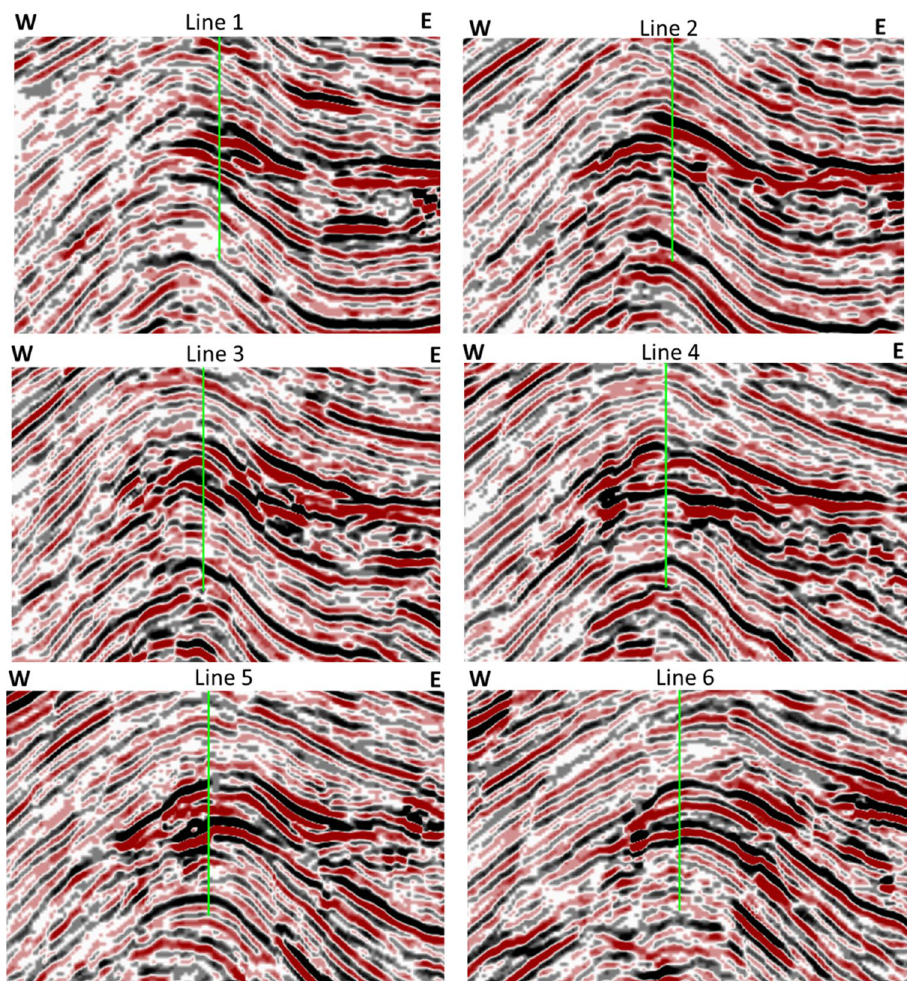
Fig. 10 Seismic lines around Well_1 (green vertical line); the well is located in the center of seismic line 3, lines 1 and 2 located to the north of the well where lines 4, 5, 6 are located to the south of the well, the line interval is five seismic lines and the line spacing is 25 m, the flat spot continues around the well, a pull down in the deeper sec- tion as observed in line